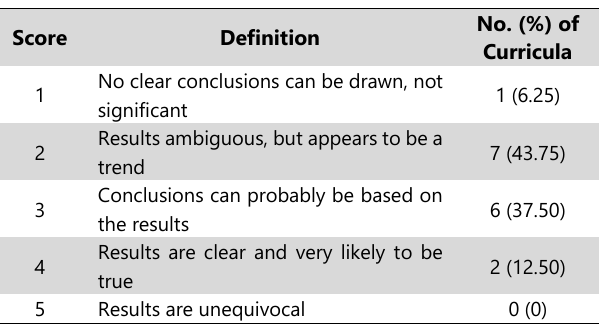
Table 3 . Quality of Evidence Using the Hammick et al Data